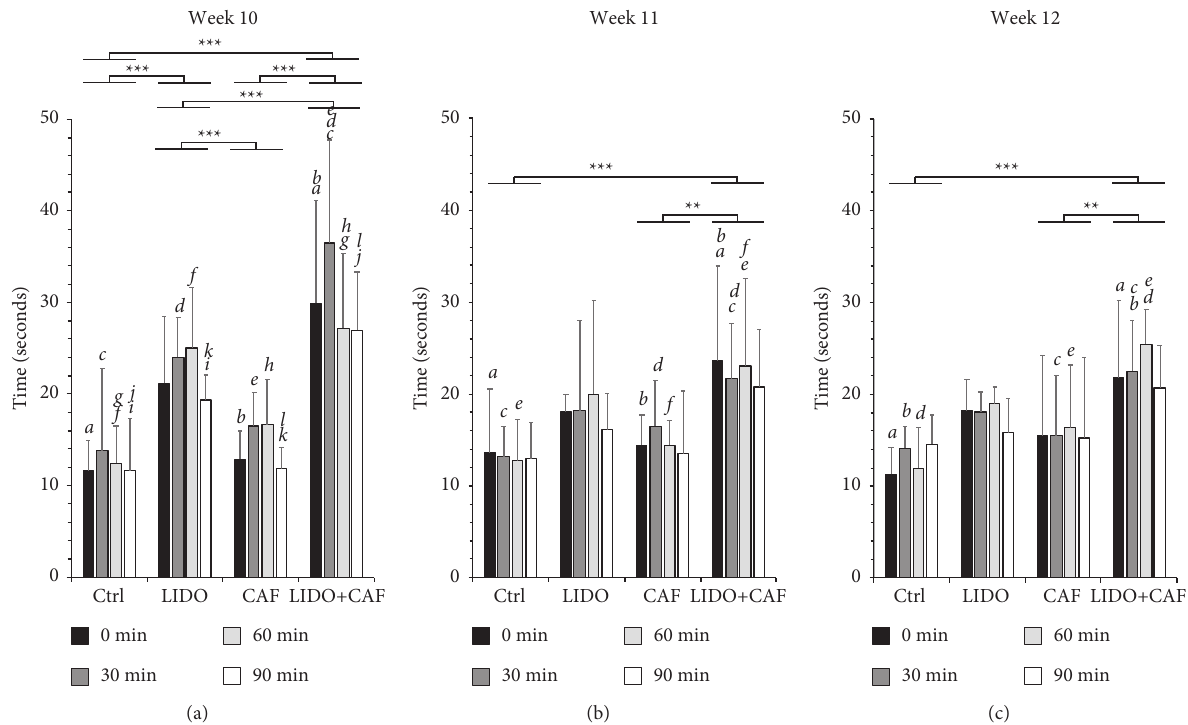
Figure 3: Effects on thermal pain sensation test. The bar graph shows the time (seconds) from the application of the heat stimulus until the rat retracted its paw and was tested 0, 30, 60, and 90 minutes after the local (intraplantar) administration of lidocaine. The rats were divided into 4 subgroups ( n � 8) as follows: control (Ctrl), receiving a local lidocaine injection (LIDO), habitual caffeine intake (CAF), and habitual caffeine intake and receiving a local lidocaine injection (CAF+LIDO). Caffeine was provided in the drinking water to the respective groups for 10-week (a), 11-week (b), and 12-week (c) periods. The statistical analysis was performed using a linear mixed model with repeated measures, and the main effects and time-specific differences were compared with adjustment using the Bonferroni test. Significant dif- ferences between the experimental groups are shown with the connecting bars and asterisks ( ∗ < 0 . 05 , ∗∗ < 0 . 01 , ∗∗∗ < 0 . 0001 ) . Significant differences between the groups for the individual time points are indicated with small letters, where every two similar letters indicate a statistically significant difference ( P < 0 . 05 ) between the two groups they represent for the specific time